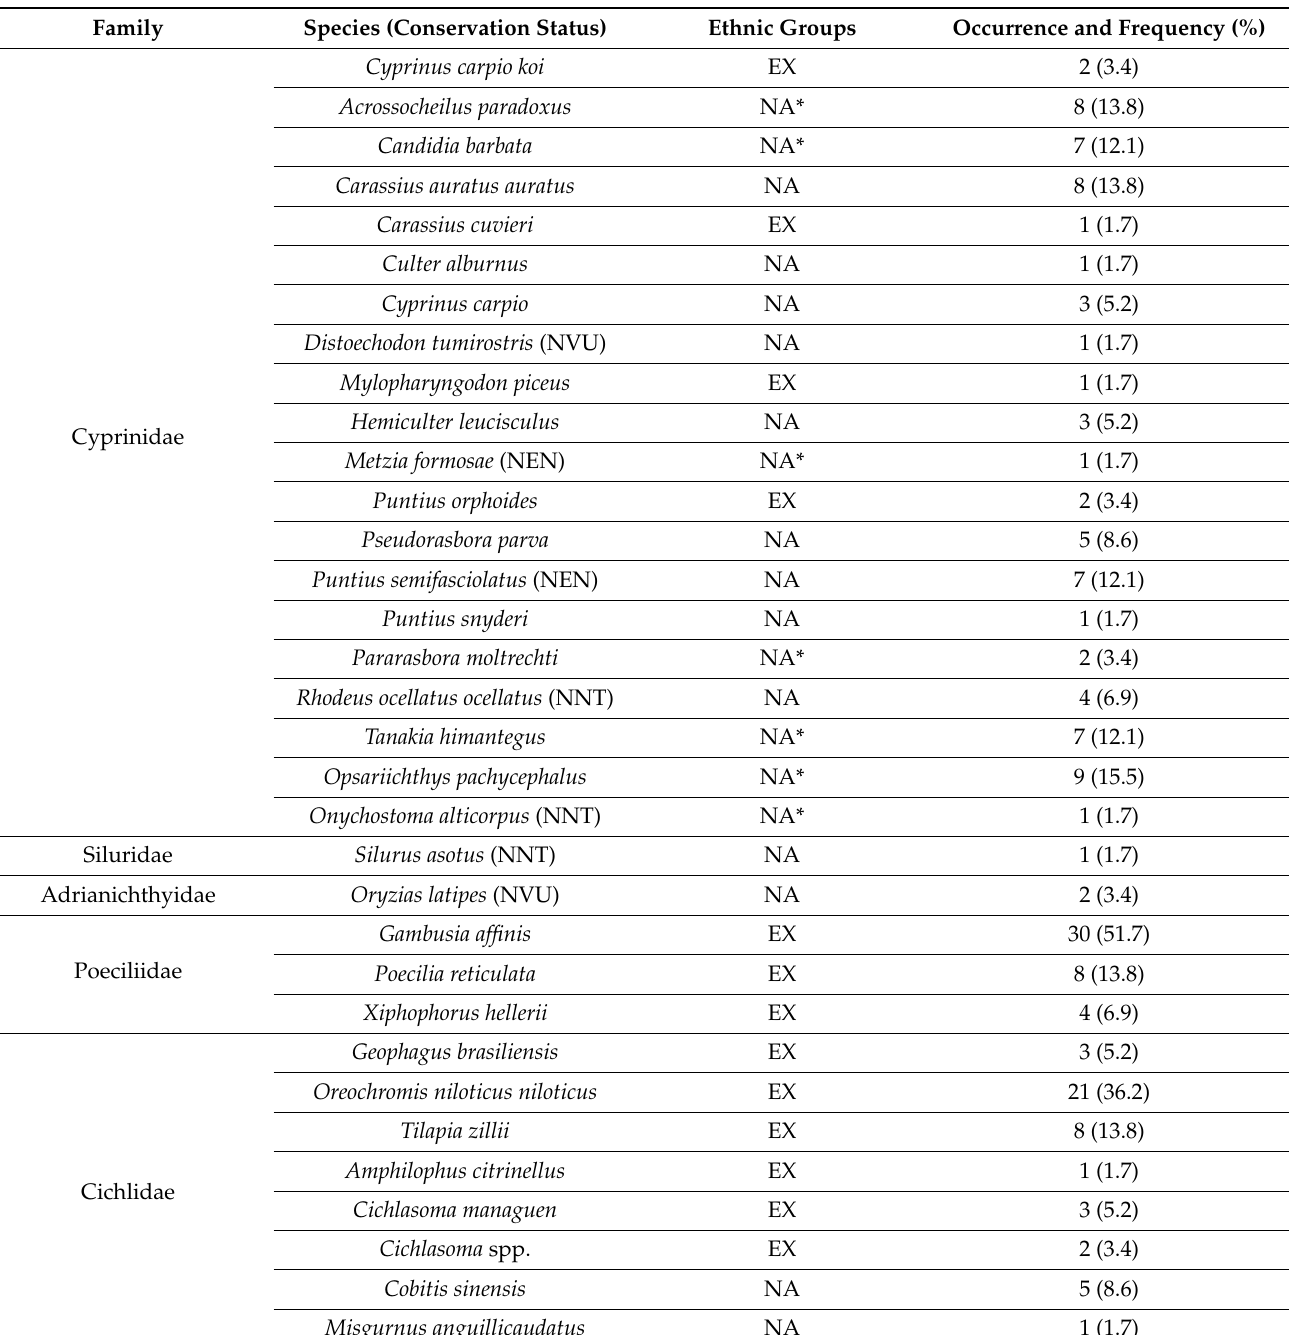
Table 3. The Taiwan conservation status and occurrence and frequency of recorded fish species in 58 sampled springs of Taiwan. The Taiwan conservation status are based on Yang et al. [23]. (Conservation status: NVU: Nationally Vulnerable, NEN: Nationally Endangered, NCR: Nationally Critical, NNT: Nationally Near-Threatened) (Ethnic groups: Exotic species (EX)/Native species (NA)/Endemic species